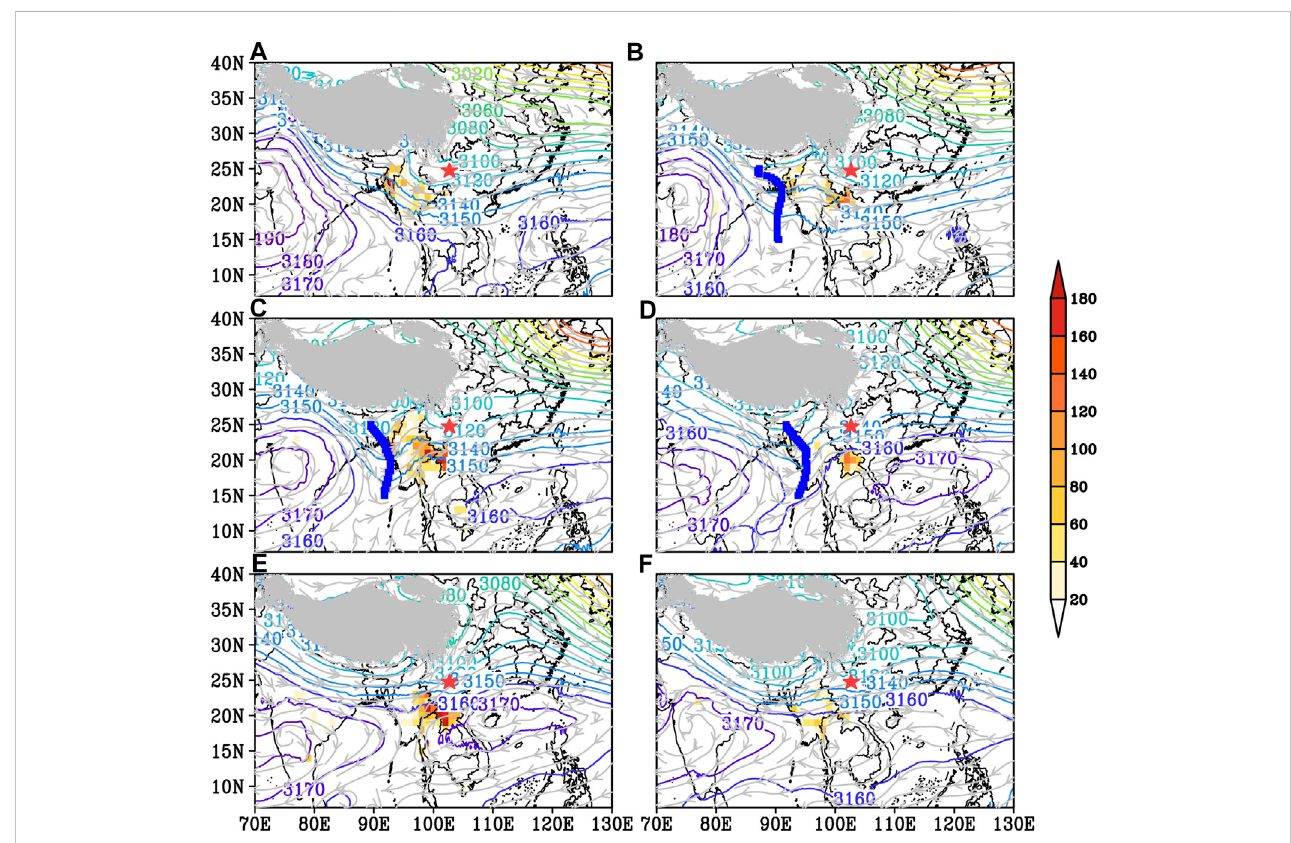
FIGURE 7 The daily means wind streamline and geopotential height (contour, gpm) at 700 hPa with ground fi re counts (shaded) from 28 March to 2 April 2019 (A – F) . The blue lines represent the location of the trough line and the red star denotes the location of Kunming